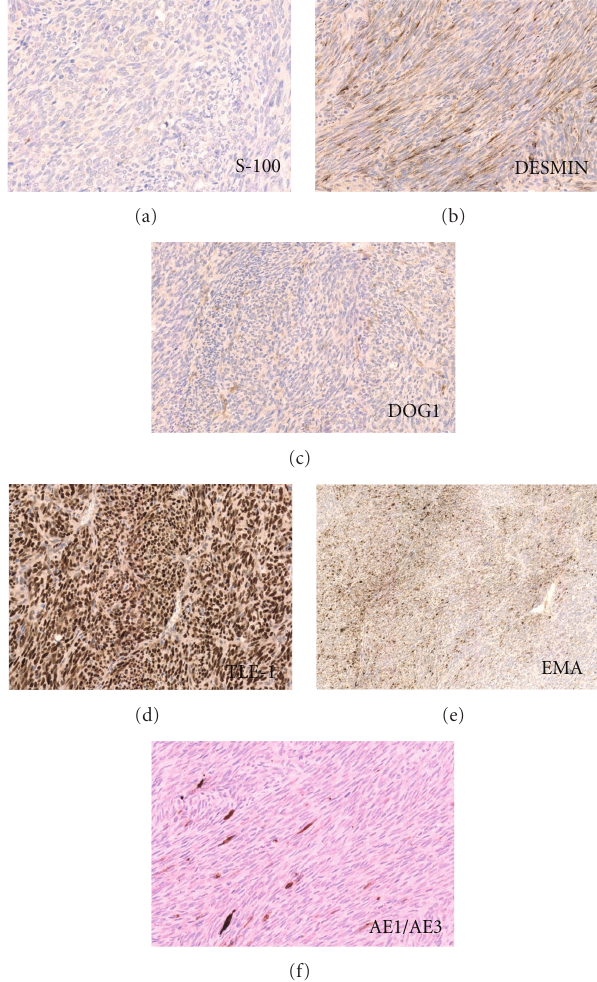
Figure 3: Immunophenotype of tumor cells (tumor cells were focal EMA, AE1/AE3, desmin, and di ff use intranuclear TLE-1 positive; they are negative for S100 and